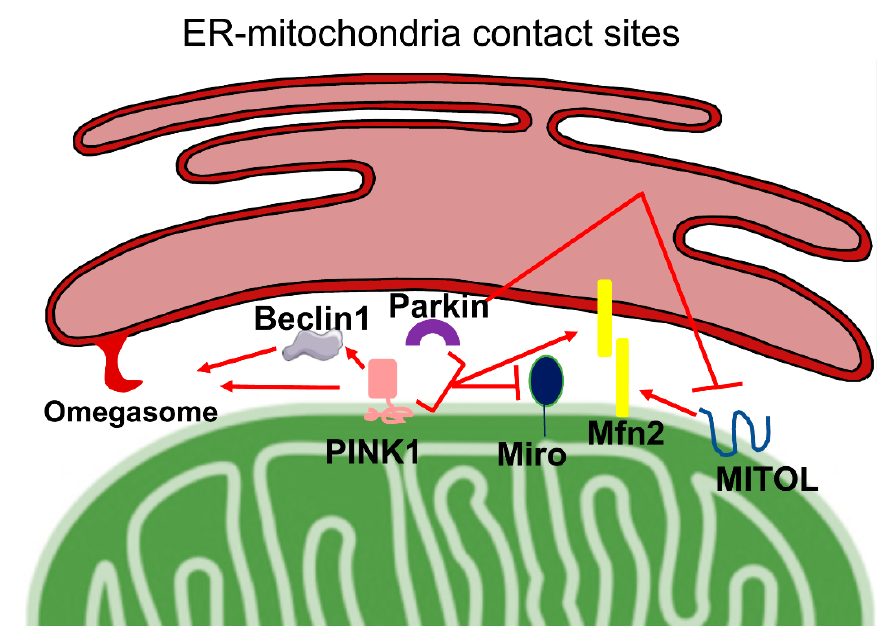
Figure 3. PINK1, Parkin, and endoplasmic reticulum (ER)–mitochondria tethering. PINK1 and Parkin are found enriched at ER–mitochondria contact sites. Upon treatment with CCCP, PINK1 localization is markedly increased in the ER–mitochondria interface, where it recruits Beclin-1, a pro-autophagic protein. ER–mitochondria juxtaposition and omegasome formation (a process that occurs at ER–mitochondrial contact sites) are enhanced upon PINK1-mediated Beclin-1 recruitment, red arrows. Miro1 protein, an OMM Rho GTPase 1, which tethers mitochondria to microtubules and regulates their movement, is a PINK1 substrate, red arrow.